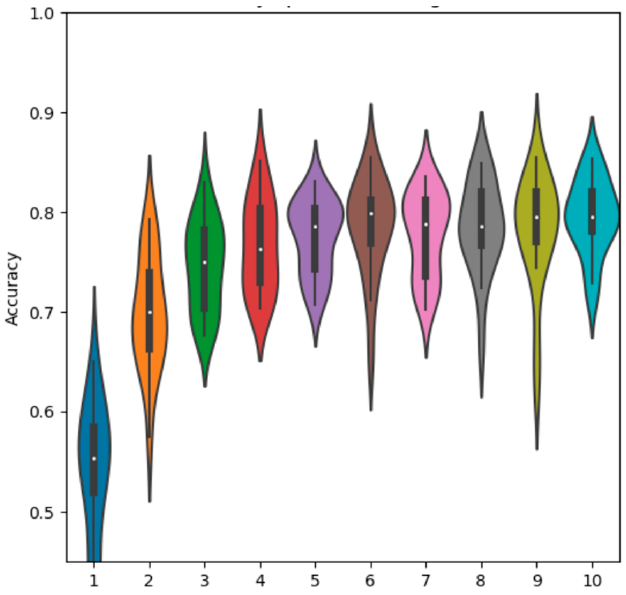
Figure 19. Accuracy distributions of simple net decision fusion vs. SAR and EO by epoch.